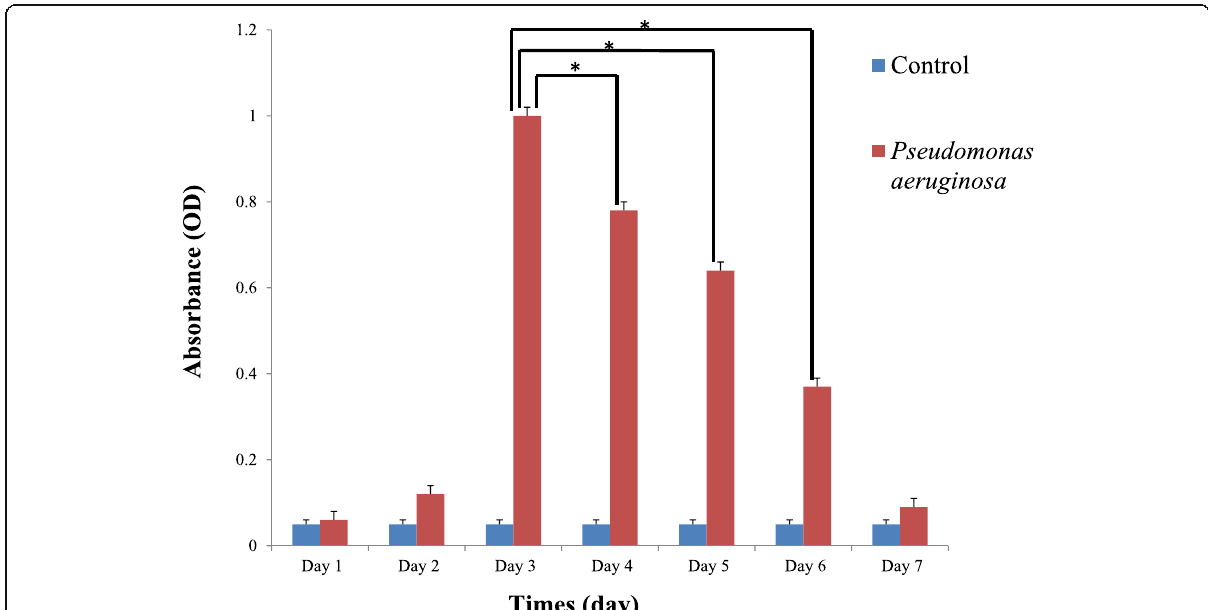
Fig. 2 Biofilm formation by P. aeruginosa. Quantitative biofilm analysis for 7 days in microtiter plate. Asterisk* indicates the mean differences were significant ( p ≤ 0.05)